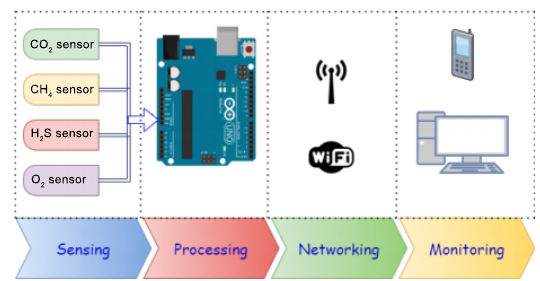
Fig. 2 Architecture of the proposed system.